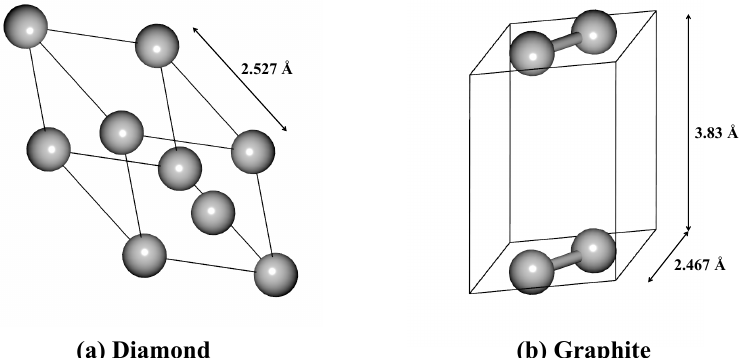
Figure 1. Structures for the primitive cells of diamond and graphite. The solid line is the boundary of the primitive cells, and the atoms on the boundary are